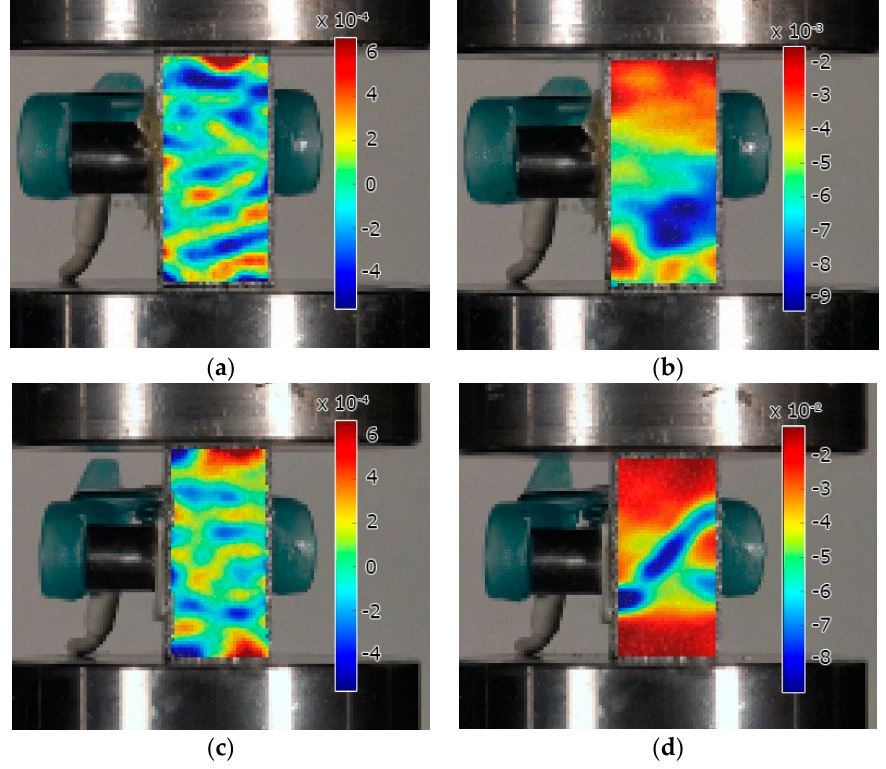
Figure 7. Surface ε yy strain maps at different macroscopic strain: ( a ) Al foam at 2%; ( b ) Al foam at 4%; ( c ) AlSi12 foam at 2%; ( d ) AlSi12 foam at 4%. (The scale of ε yy strain is different in each figure.).